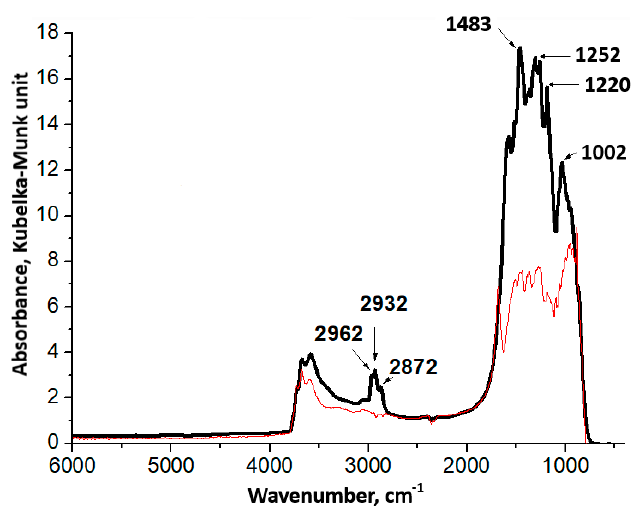
Figure 5. Diffuse reflectance infrared Fourier transform spectroscopy (DRIFTS) spectra of PdMn-1-330 without pretreatment (red line) and treated with C 2 H 2 and H 2 (black line).